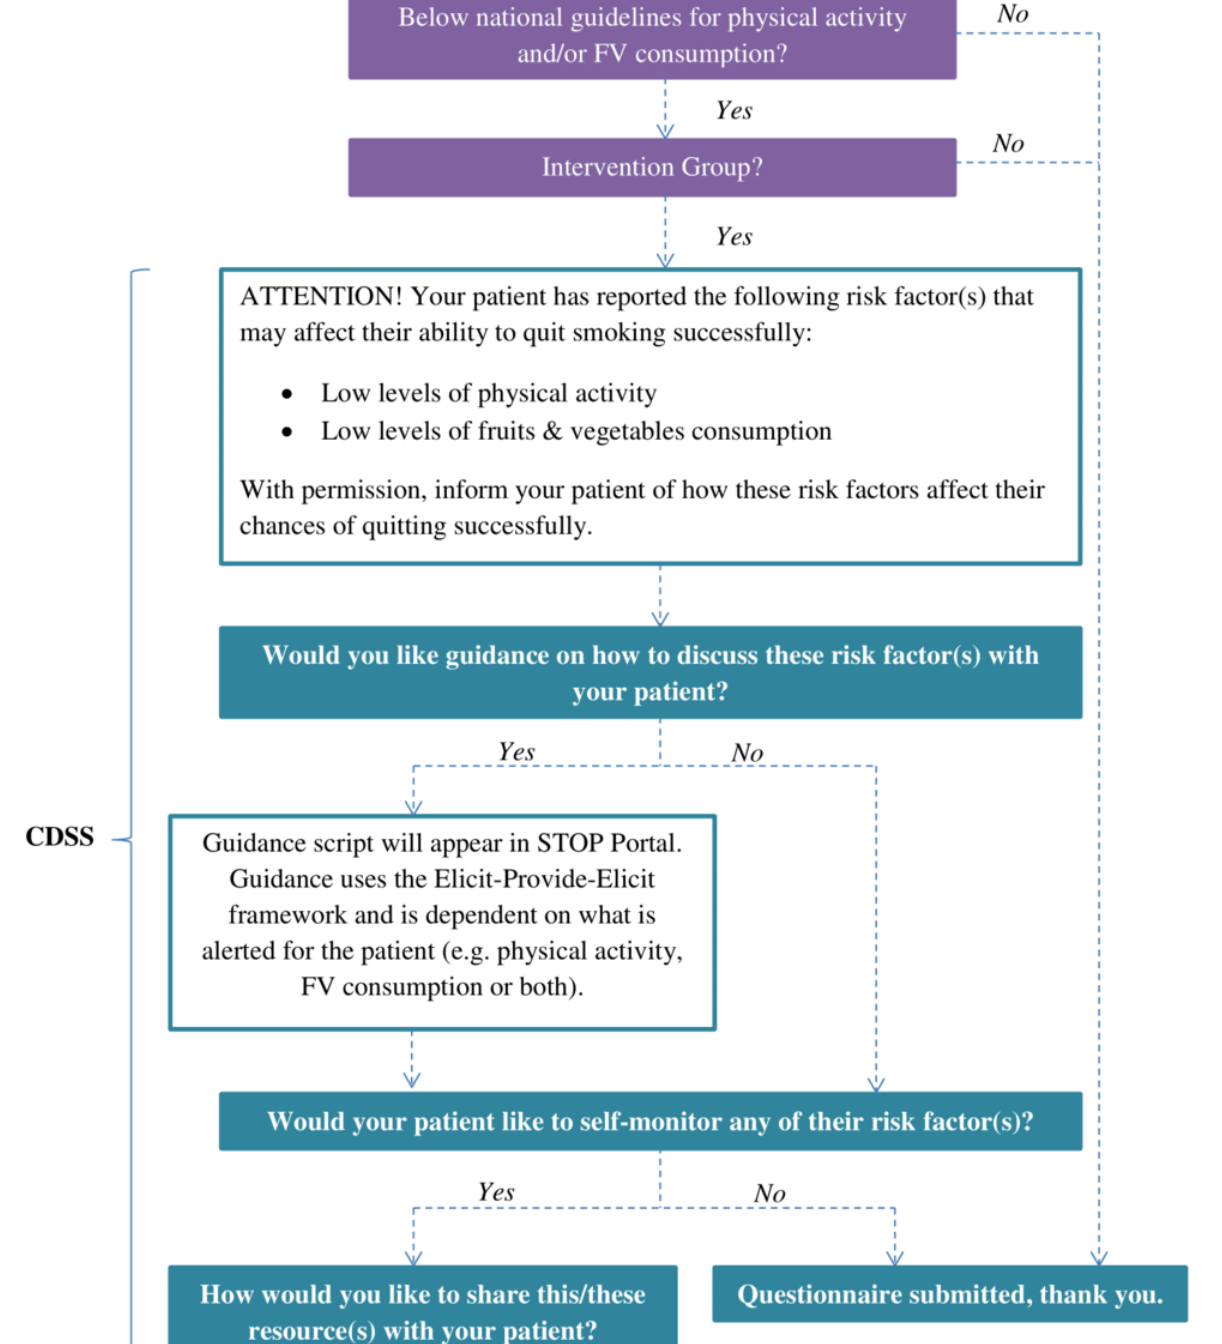
Figure 1. Study workflow diagram. FV: fruits and